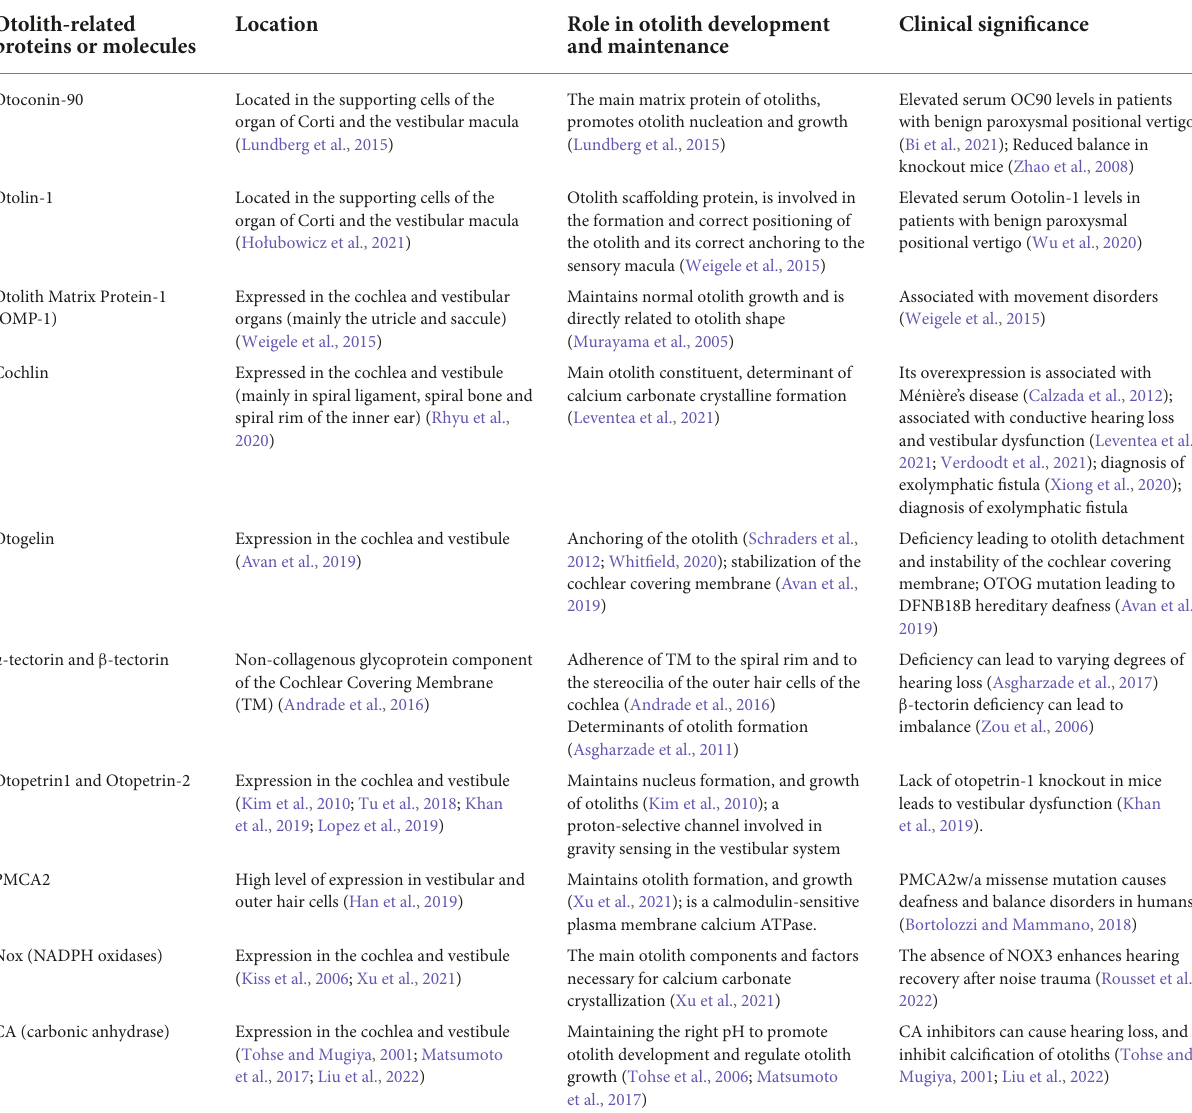
TABLE 1 Overview of otolith-related